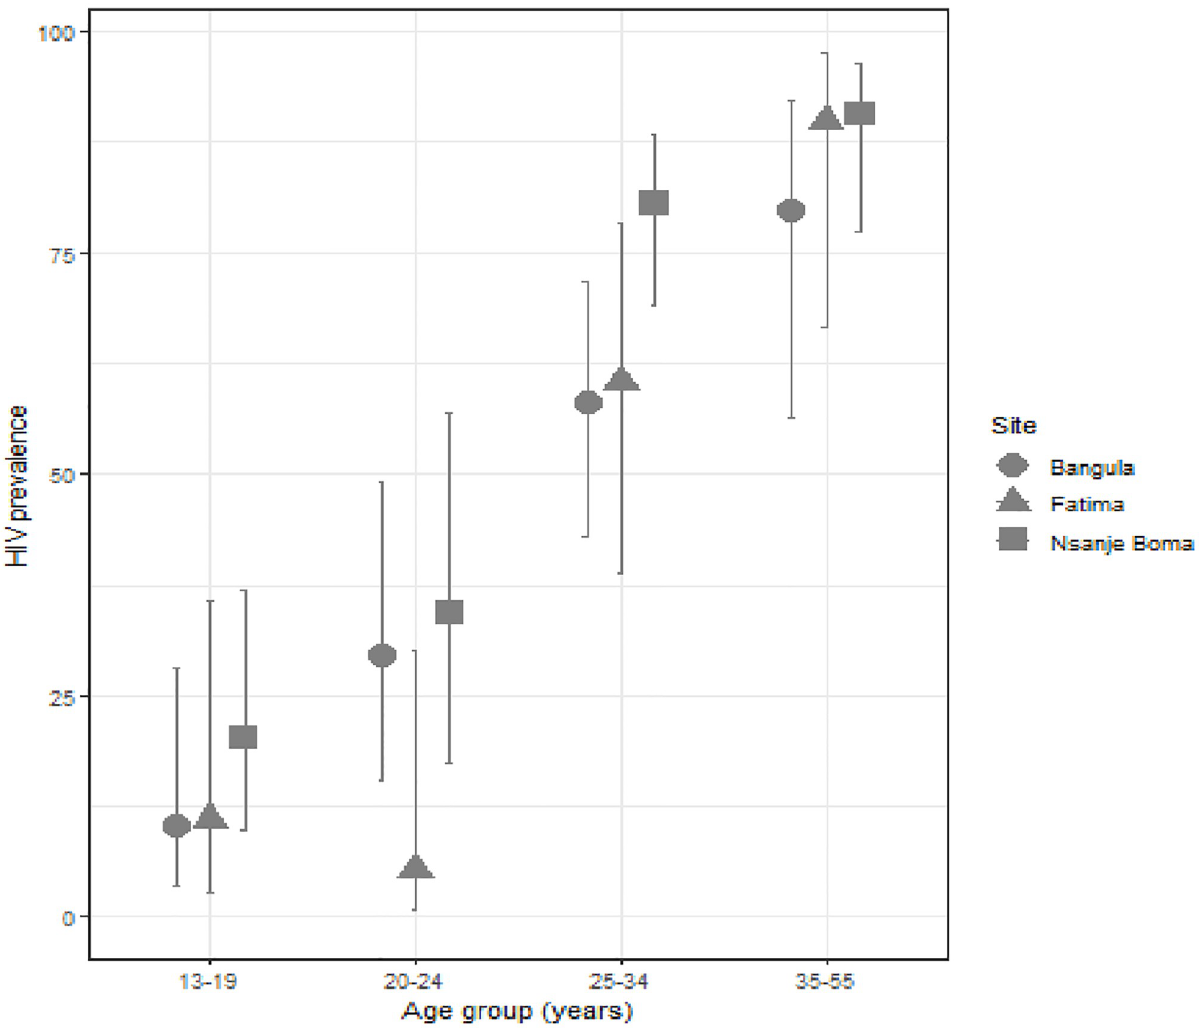
Fig 1. HIV Prevalence (%) by age group and study sites. Overall prevalence by age group: 13–19 years:14,7%; 20–24: 24.2%; 25–34: 69.5%; 35–55: 87.9%.